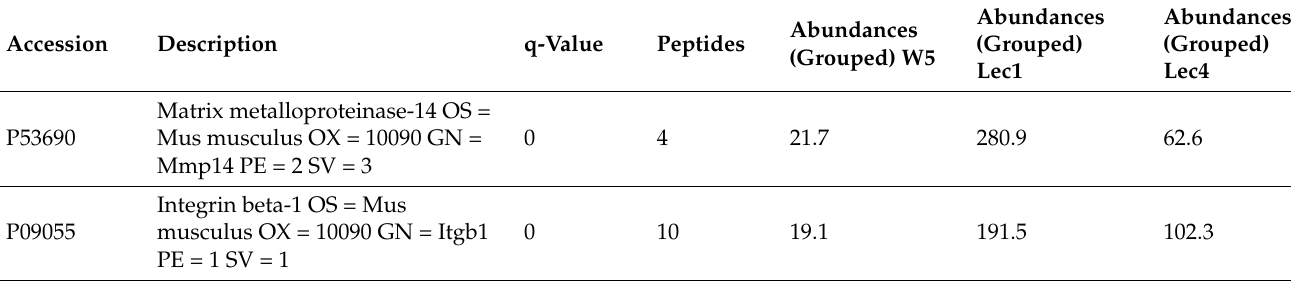
Figure 2. Identification of differentially expressed proteins from control Chinese hamster ovary (CHO) designated as W5, Lec1, and Lec4 cells using high-resolution liquid chromatograph mass spectrometry. ( A ) Venn diagram showing the overlapped proteins, indicating 37 common proteins between Lec1 and Lec4 cells; 9 proteins were present in Lec4 cells and 2 proteins were present in Lec1 cells. Venn diagram drawn using Bioinformatics and Evolutionary Genomics web tool ( https://bioinformatics.psb.ugent.be/webtools/Venn/ ) (accessed on 23 December 2021) ( B ) Heat map comparative proteomic profile among control Chinese Hamster Ovary (CHO) W5, Lec1, and Lec4 cells, generated using Hemi.exe version 1.0 software. Color bar showing ranges of blue and red color indicates downregulation to upregulation of abundance values for each protein (scale is 0.00 up to 20.00). Black bar indicates no intensity abundance values for protein in cells. Table 1. Identified proteins with their accession numbers, description, q-value, peptides, and normal- ized abundances in W5, Lec1, and Lec4 cells are